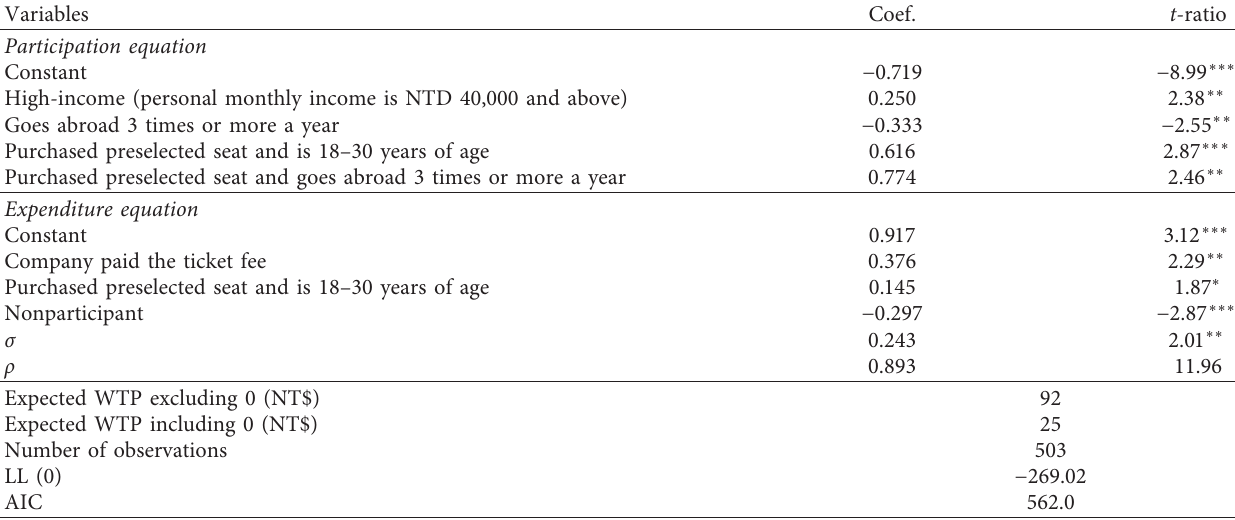
Table 8: Estimated result of the model for seat preselection (general standard